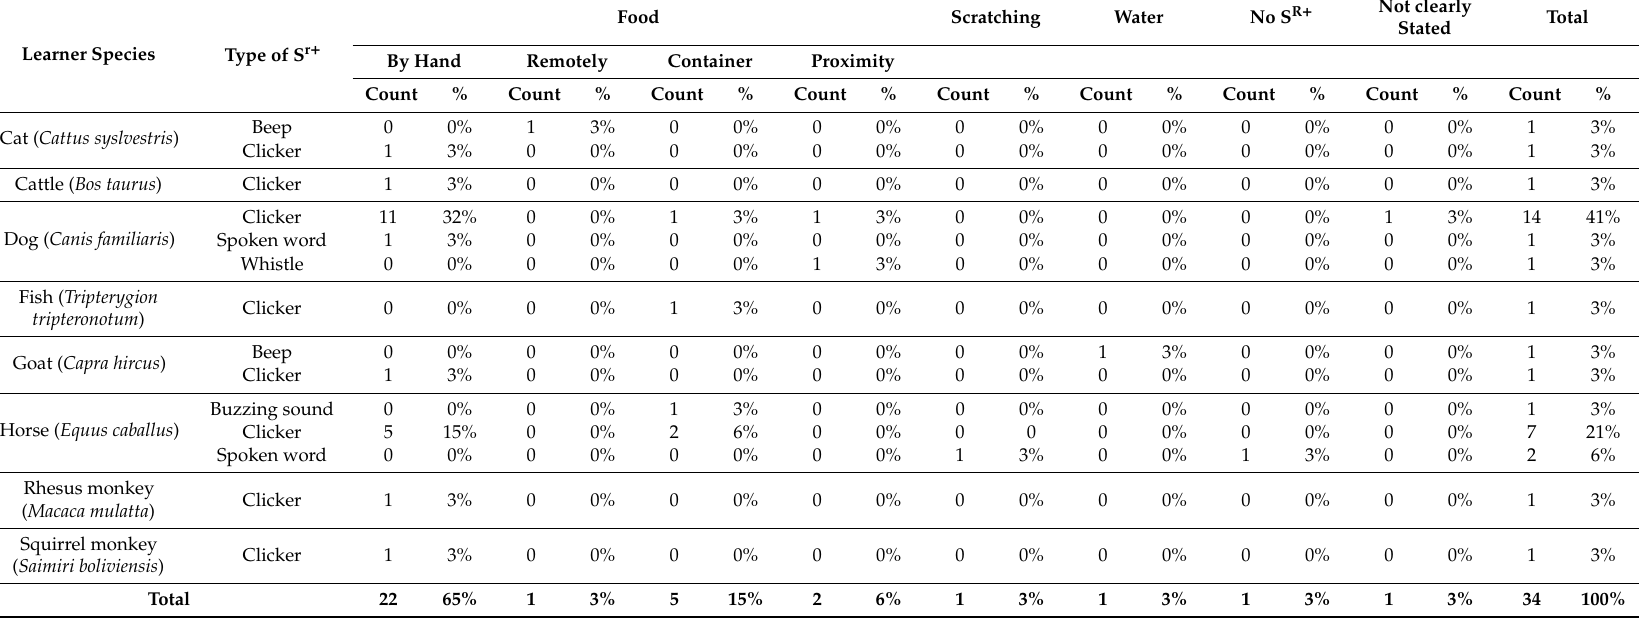
Table 3. Count and percentage of studies by species and type of conditioned reinforcers (S r + ), across types of unconditioned reinforcers (S R +